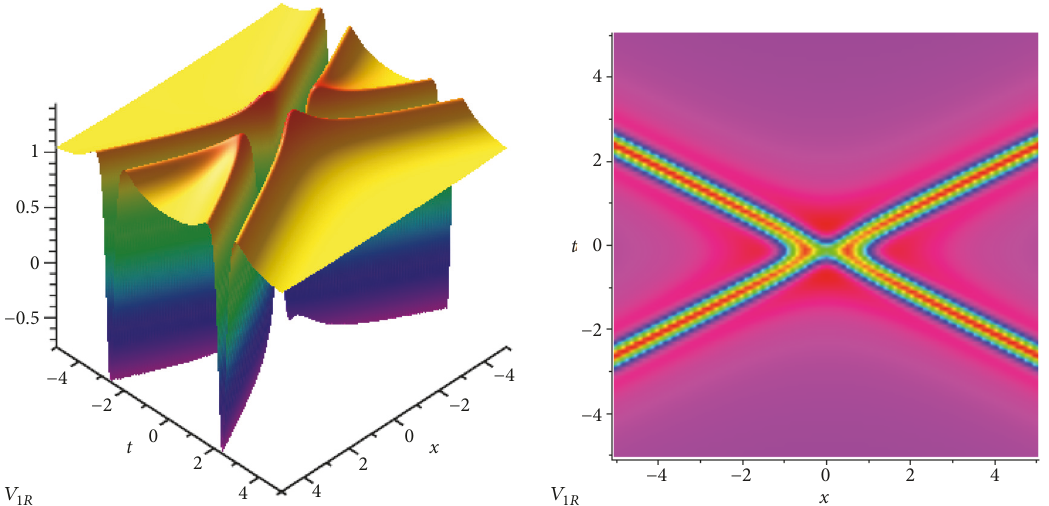
Figure 5: The real part of the PT-symmetric potential generated by the rational solution. The profile of 𝑉 1𝐼 with (𝐽 1 ,𝐽 2 ) = (2,3) .